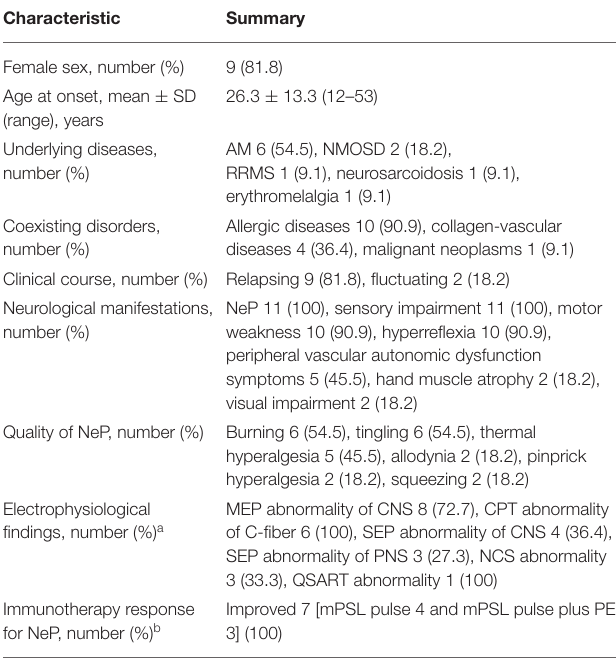
TABLE 1 | Clinical findings for 11 patients with anti-plexin D1 antibodies.